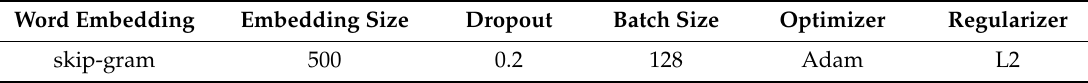
Table 2. Parameter